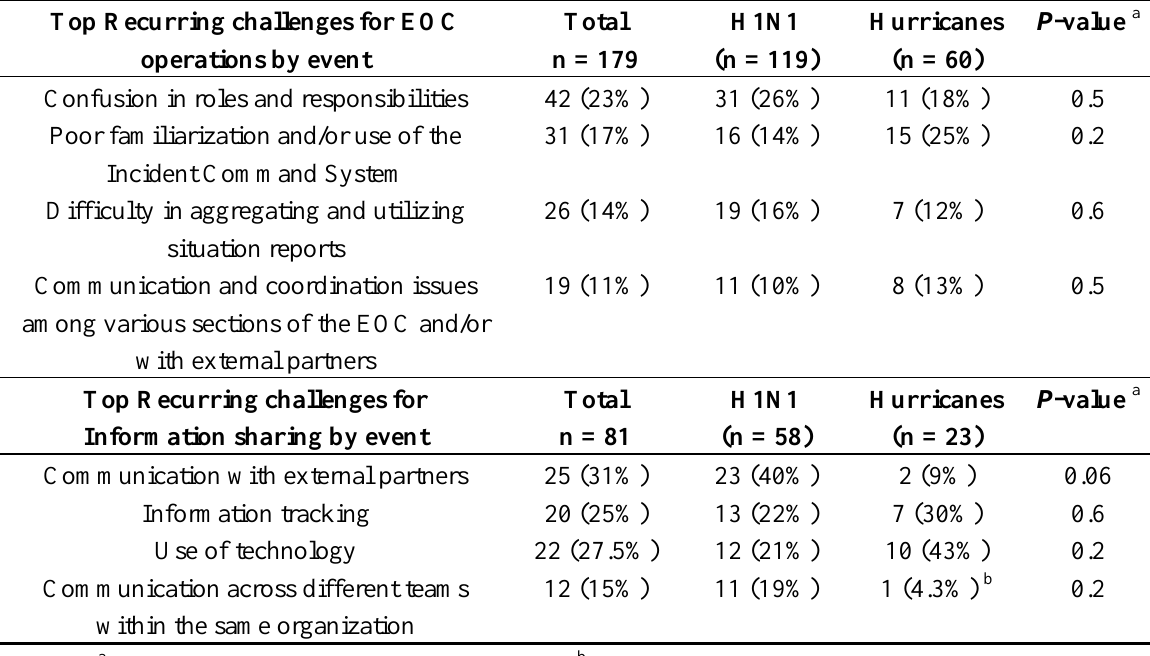
Table 4. Distribution of themes across types of